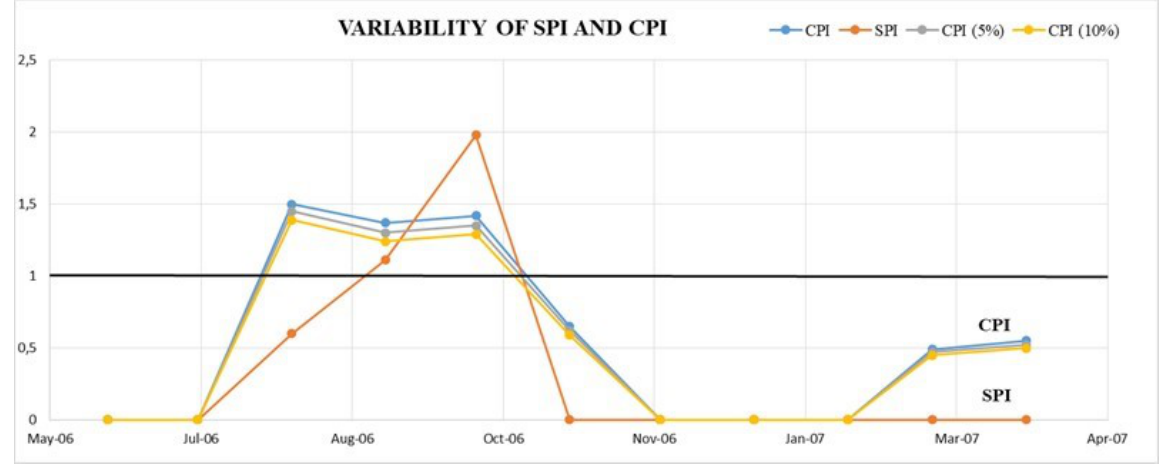
Figure 6: Variability of SPI and CPI [authors’ data]